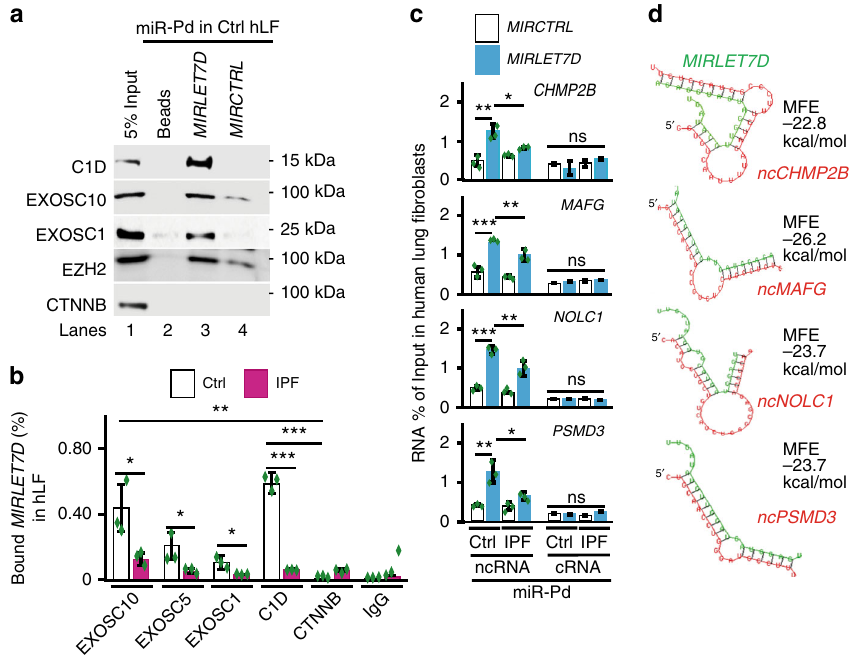
Fig. 3 MIRLET7D binds the MiCEE complex and ncRNAs from MIRLET7D targets. a Western blotting (WB) of precipitated proteins after miRNA pulldown (miR-Pd) using nuclear fraction from Ctrl primary human lung fi broblasts (hLF) and biotinylated MIRCTRL or MIRLET7D . Input, 5% of starting material. Beads, control without probe. b Mature MIRLET7D -speci fi c TaqMan assay after chromatin RNA immunoprecipitation (Ch-RIP) using the indicated antibodies and chromatin isolated from Ctrl or IPF hLF. CTNNB (beta-catenin) and IgG were used as negative controls. c qRT-PCR-based analysis of the indicated ncRNAs and cRNAs after miR-Pd from Ctrl or IPF hLF transfected with biotinylated MIRCTRL or MIRLET7D . d In silico analysis of ncRNAs from MIRLET7D target genes (magenta) identi fi ed MIRLET7D (green)-binding sites. MFE, minimum free energy. In all bar plots, data are shown as mean (SD) ( n = 3 biologically independent experiments). Asterisks in all plots, P -values after unpaired t -test, two tailed, *** P < 0.001; ** P < 0.01; * P < 0.05; ns, not signi fi cant. Source data are provided as a Source Data fi